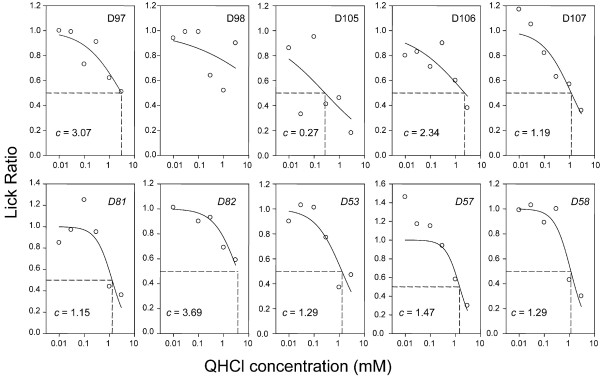
Concentration-response functions for QHCl in 10 individual D2 mice. Data points for each mouse represent average ratios across two days of testing; these means were fitted with two-parameter logistic functions and the concentration evoking half-maximal avoidance, c, was estimated. For one mouse (D98) this parameter could not accurately estimated, although this mouse had a mean lick ratio of 0.52 for 1 mM QHCl. Italicized mice (D81, D82, D53, D57, D58) were given QHCl as the last of three stimuli, as opposed to the others which received QHCl as the first stimulus.